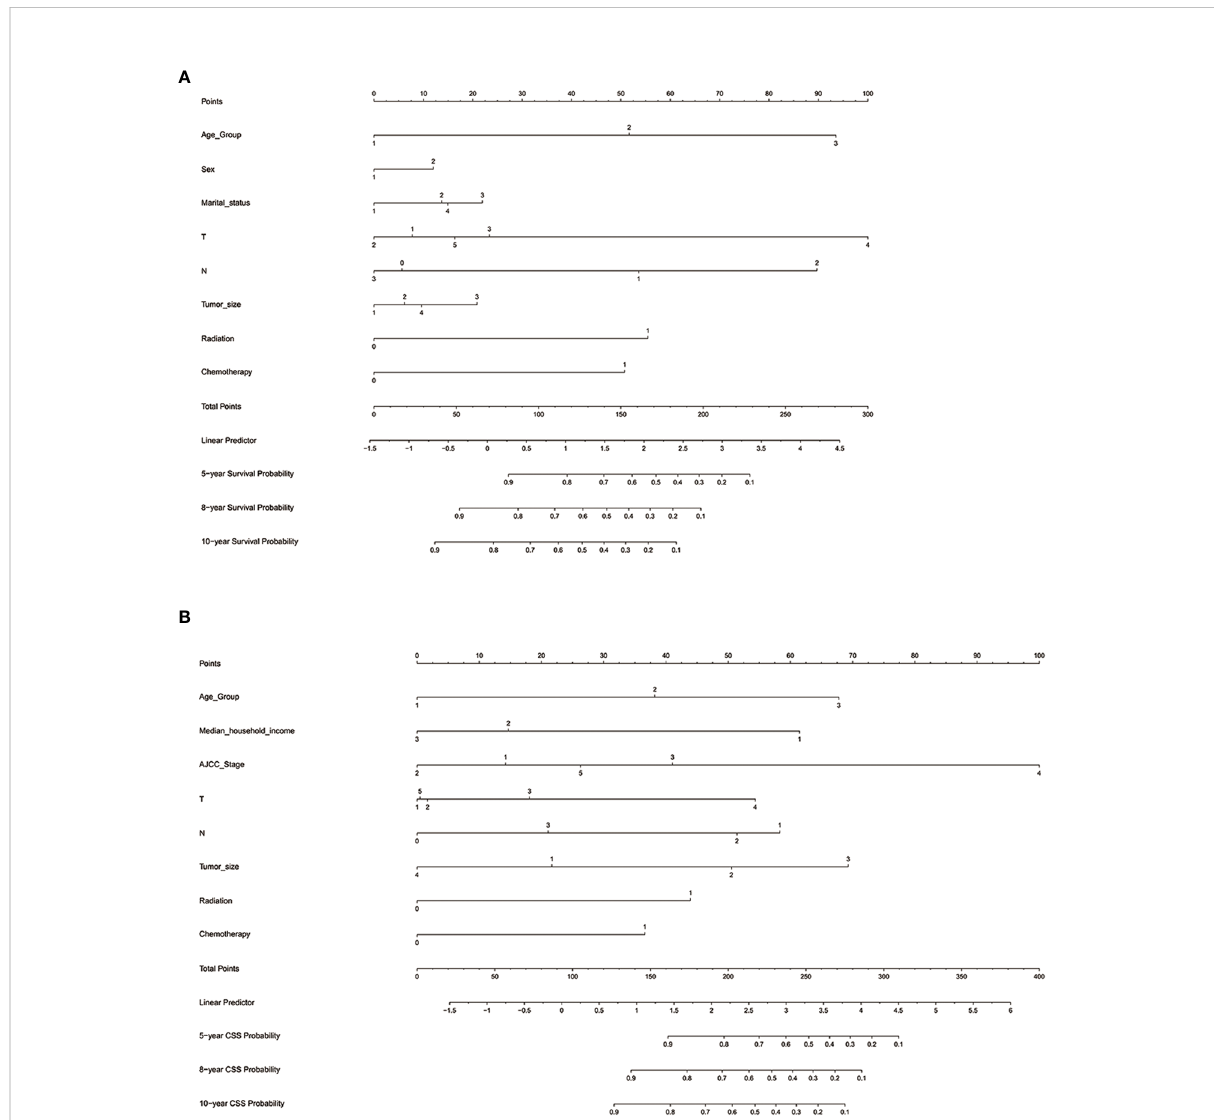
FIGURE 6 Nomograms for predicting 5-, 8-, and 10-year (A) OS and (B) CSS. OS, overall survival; CSS, cancer-speci fi c survival; AJCC, American Joint Commission on Cancer; Marital status (Other): Divorced and